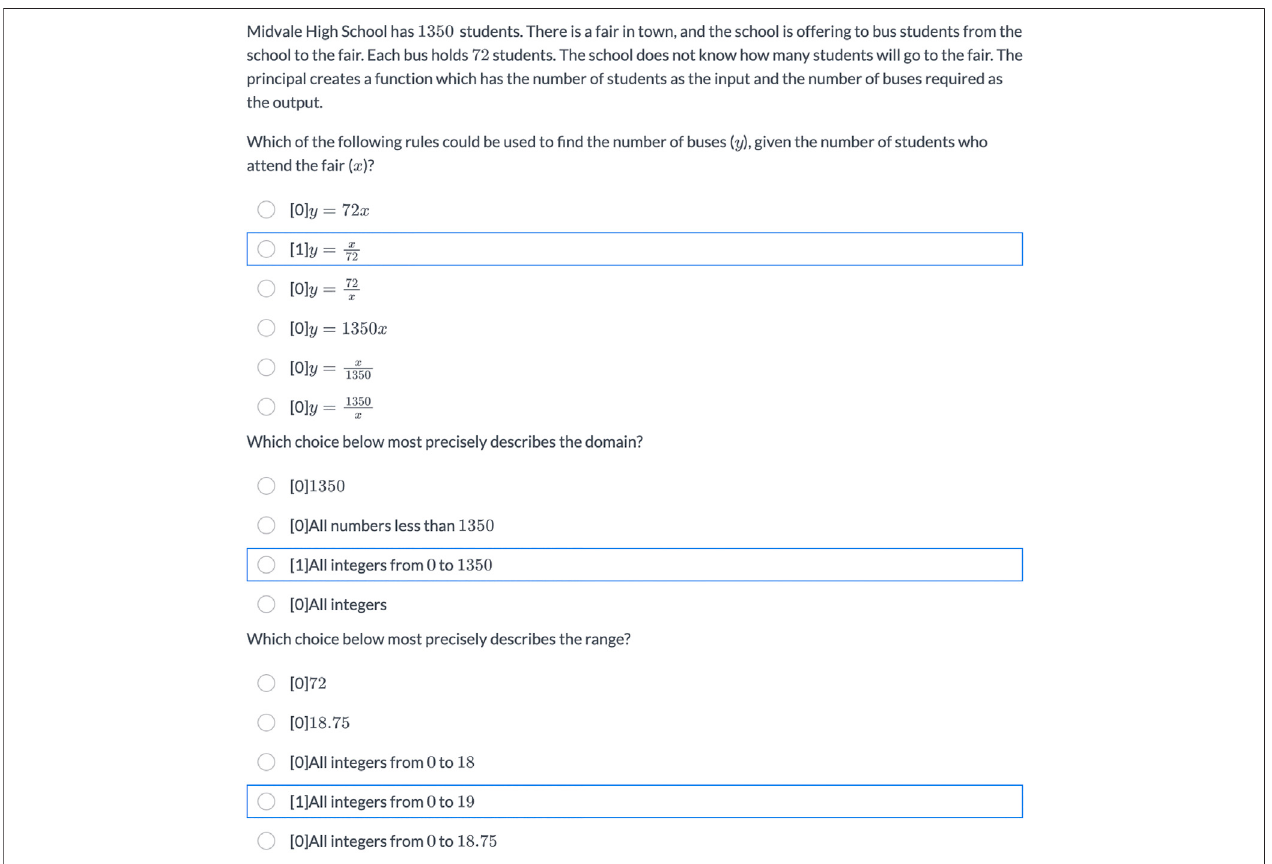
FIGURE 5 | Item 1265 aligned to Level 5 “ Given verbal descriptions of two-variable relations, graphs, or equations for linear functions, identi fi es their domain and range (including contextual restrictions) ” ; dif fi culty parameter b (cid:1) 2.17 (predicted: